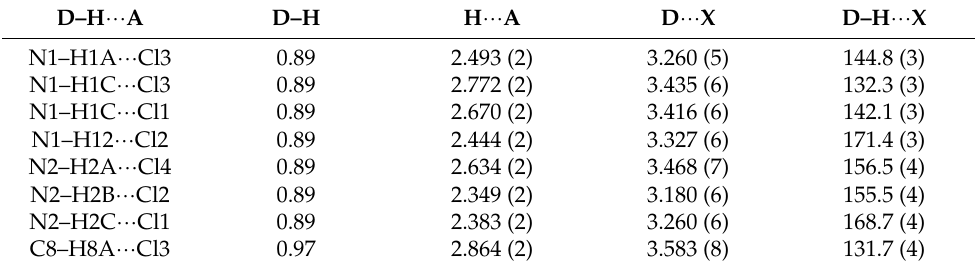
Table 3. H-bond geometry (Å, ◦ ) of (CHBMAH 2 )ZnCl 4 , 4